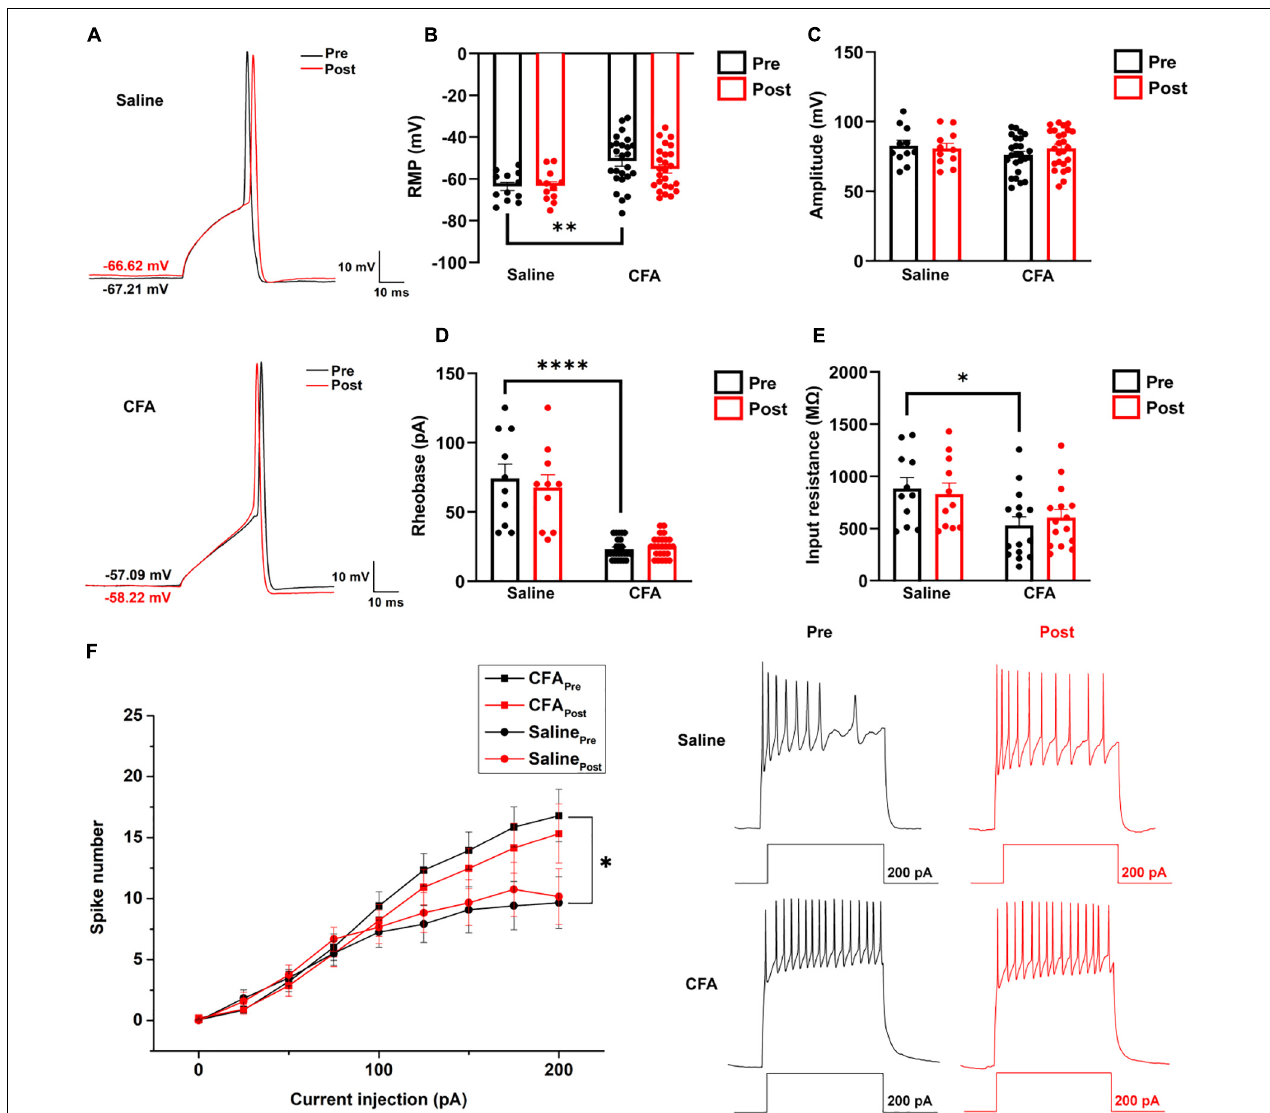
FIGURE 5 | The effect of proanthocyanidins on the intrinsic properties of PBN-projecting neurons in the spinal dorsal horn. (A) Representative samples showing a single action potential of one PBN-projecting neuron before and after the application of proanthocyanidins in saline and CFA group, respectively. Application of proanthocyanidins did not change the resting membrane potential (RMP) (B) , amplitude (C) , rheobase (D) , and membrane input resistance (E) in the CFA or saline group. (F) Application of proanthocyanidins did not change the neuronal spike number in the CFA or saline group. ∗ P < 0.05; ∗∗ P < 0.01; ∗∗∗∗ P < 0.0001. RMP, resting membrane potential; CFA, Complete Freund’s